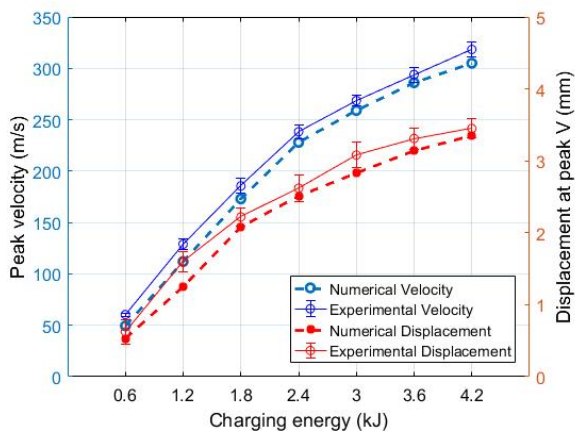
Figure 8. Peak velocities and corresponding displacements.